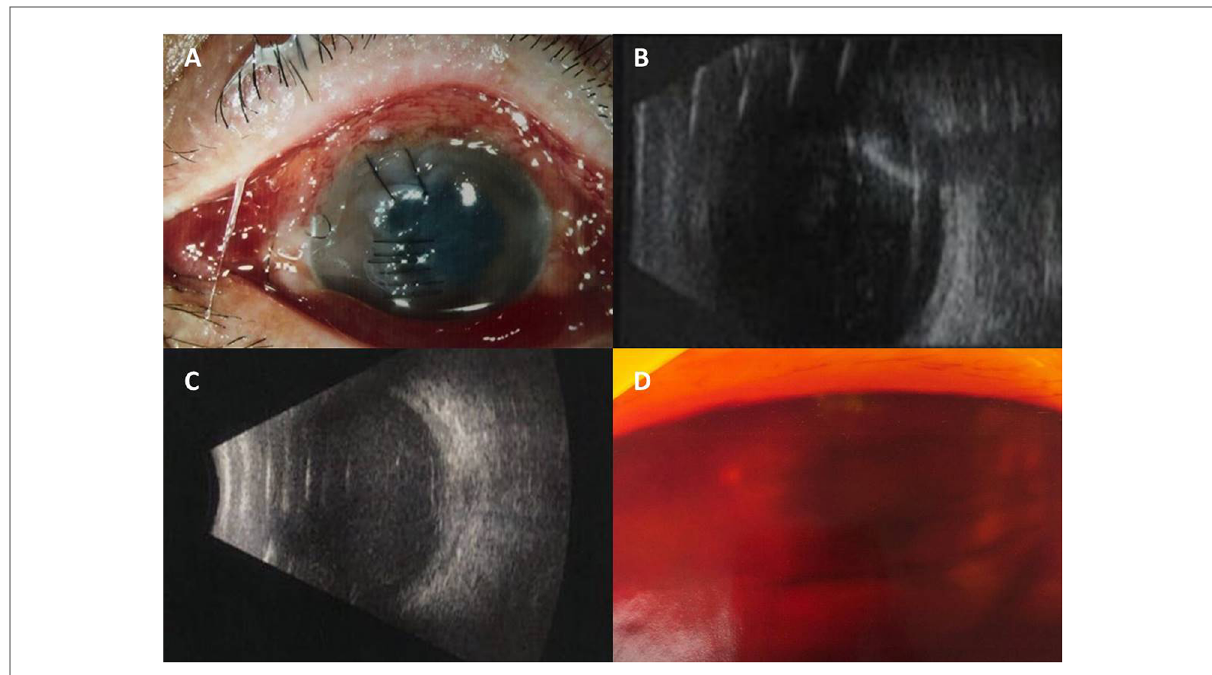
FIGURE 3 Anterior segmental fi ndings before and after surgery: case 2. ( A ) At presentation, corneal laceration and edema were seen. ( B ) Vitreous organization and the echo of the foreign body before surgery. ( C ) Vitreous hemorrhage, edema of choroid and Tenon ’ s capsule, and incomplete retinal detachment after surgery. ( D ) Vitreous hemorrhage slightly absorbed after